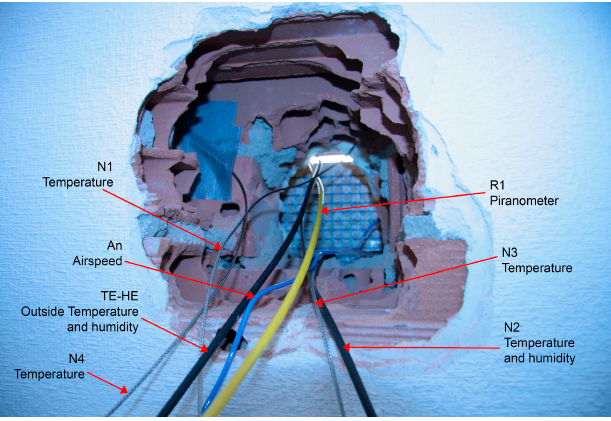
Figure 10. Location of sensors in the enclosure layers.